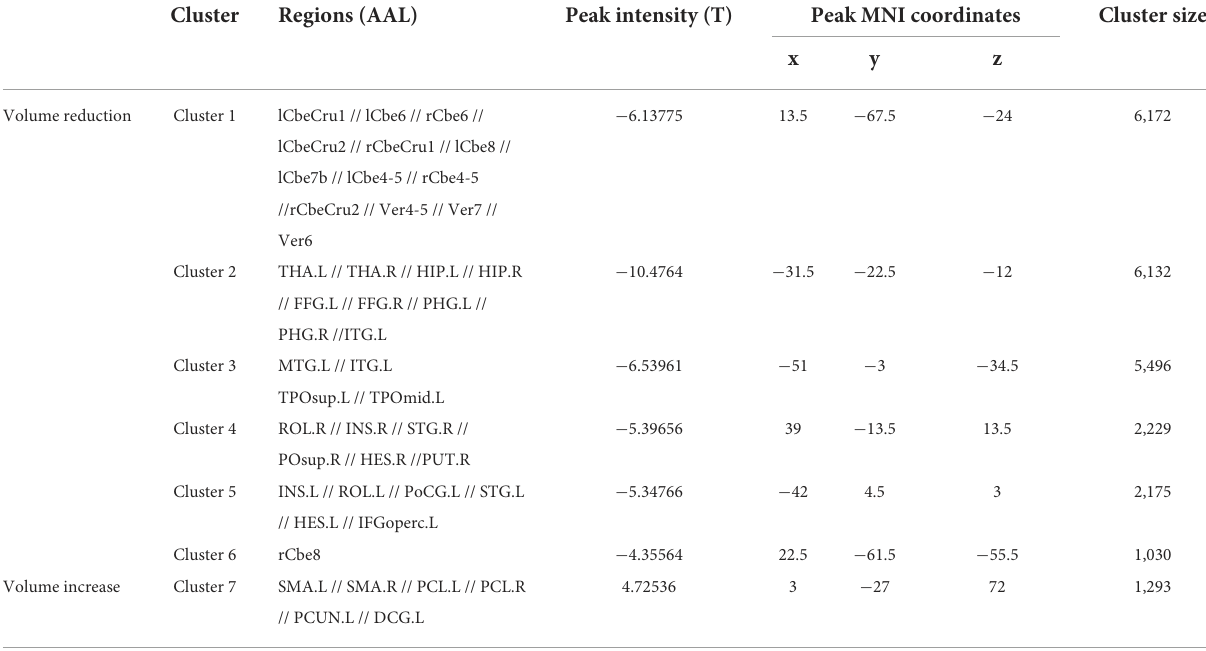
TABLE 2 Differences between clusters of the iNPH and NA groups.